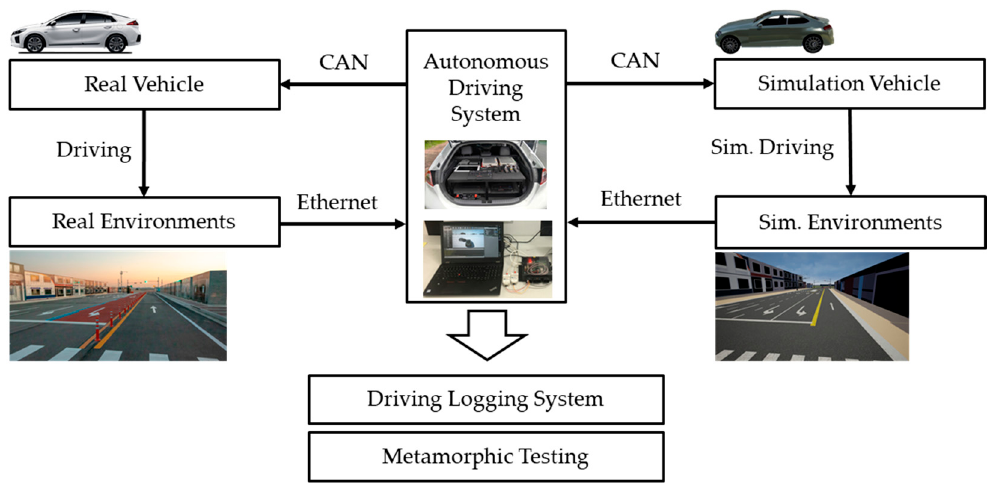
Figure 10. Experiment setting—real vs. simulation.